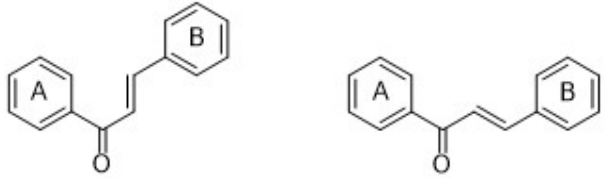
Figure 14. Chemical structure of phloretin (PH). Figure 13. General structure of Figure 13. General structure of chalcones.